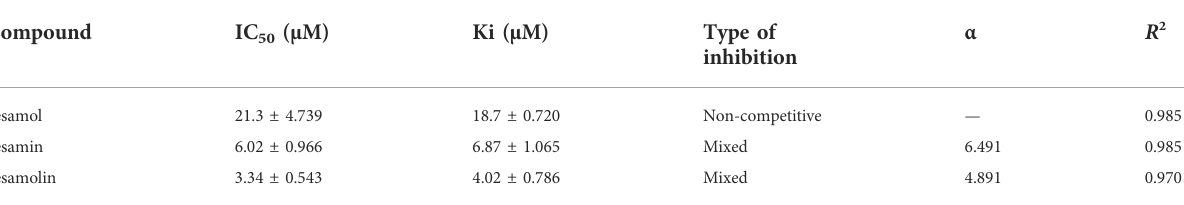
TABLE 1 The inhibitory kinetic parameters of sesame lignans on